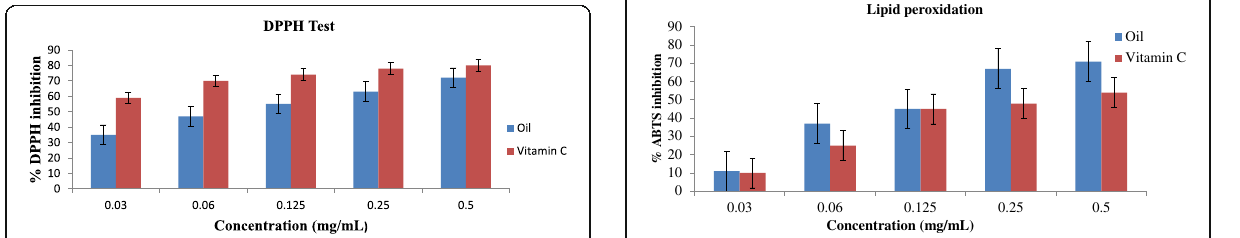
Fig. 2 Antioxidant effect of essential oil of T. minuta flower and vitamin C on DPPH radical